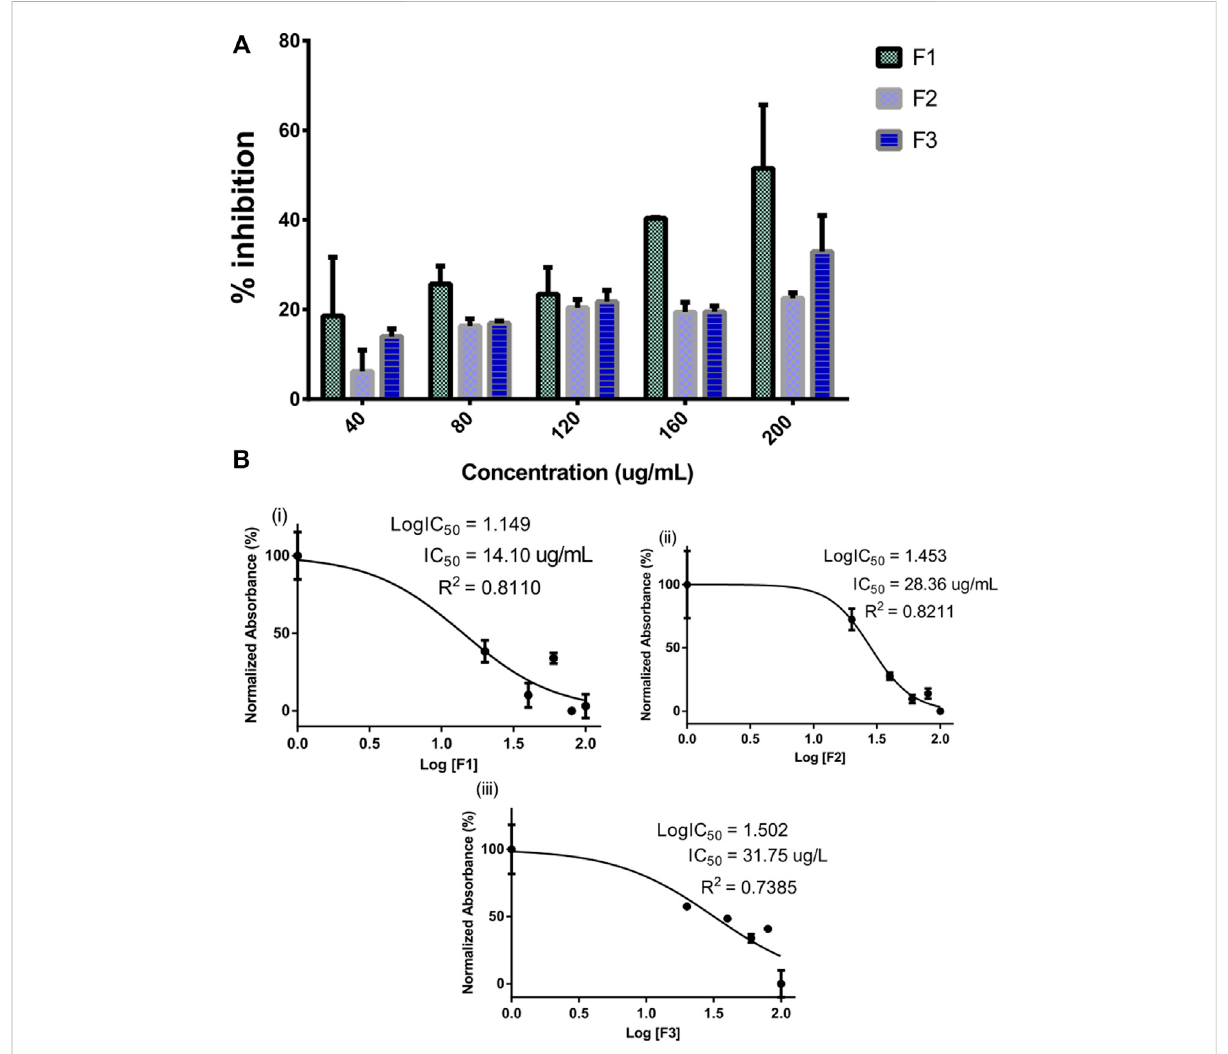
FIGURE 2 Inhibitory activity of bioactive fractions of Gongronema latifolium Benth. against alpha-amylase. Percentage inhibitory activity of the selected pregnane-rich chromatographic sub-fractions on porcine alpha-amylase (A) . Half-maximal inhibitory concentrations (IC50) of the pregnane-rich fractions (B)